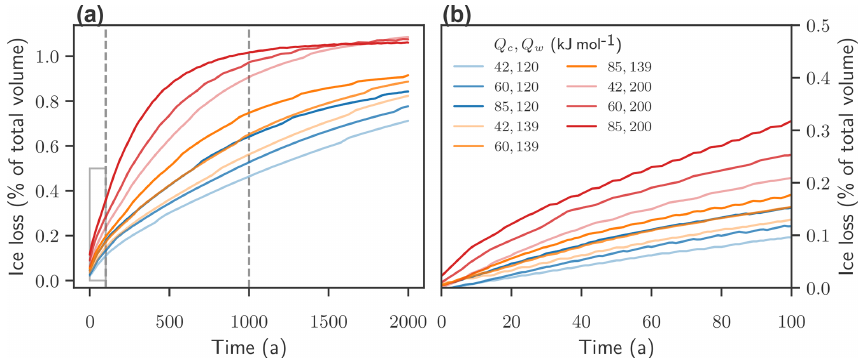
Figure 6. Time series for flow-driven ice discharge under 2 ◦ C warming: (a) time evolution of ice loss with different activation energies Q c and Q w and the flow exponent n = 3, subject to a temperature anomaly forcing of (cid:49)T = 2 ◦ C. (b) Zoom on the first 100 years.